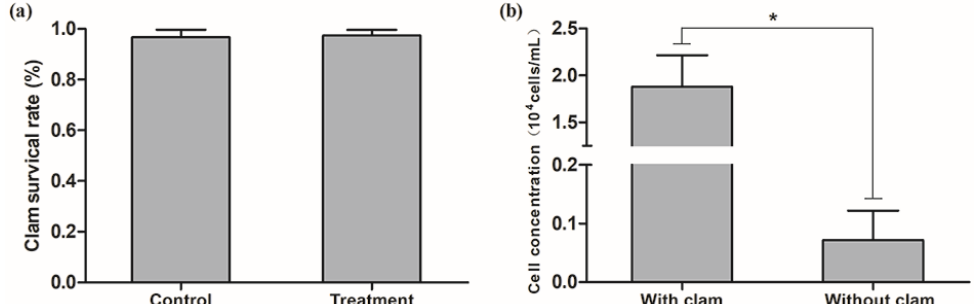
Figure 1. Effect of Heterosigma akashiwo exposure on the survival rate of the clam Meretrix meretrix ( a ). Changes in Heterosigma akashiwo concentrations under different conditions ( b ). Error bars represent standard deviations (n = 3). Asterisk (*) represents that cell concentration of Heterosigma akashiwo was significantly different between two groups ( p < 0.05).